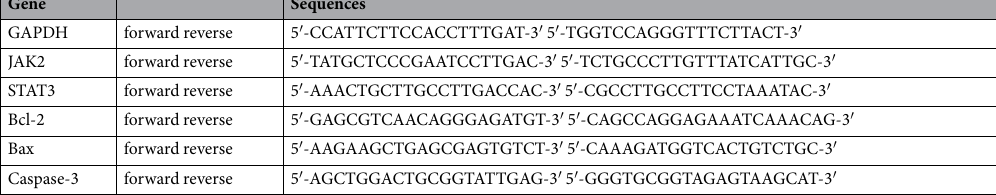
Table 1. Primer sequences used for the PCR